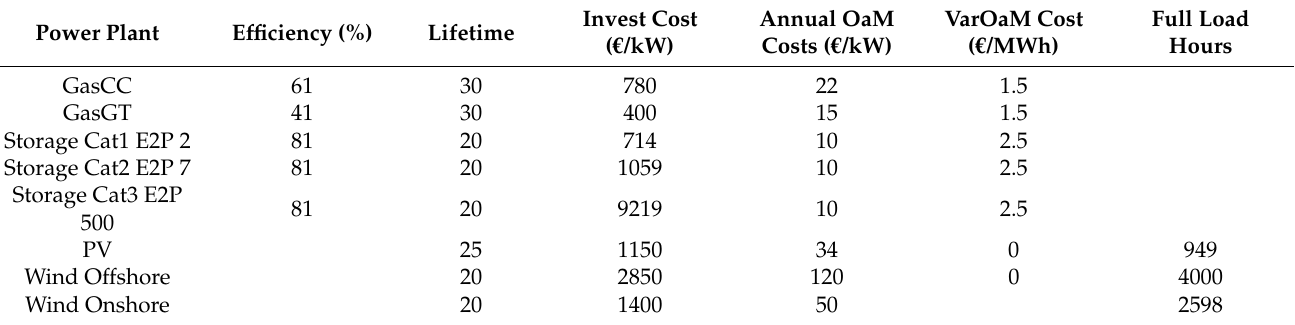
Table A2. Data for power plant investment options, data source